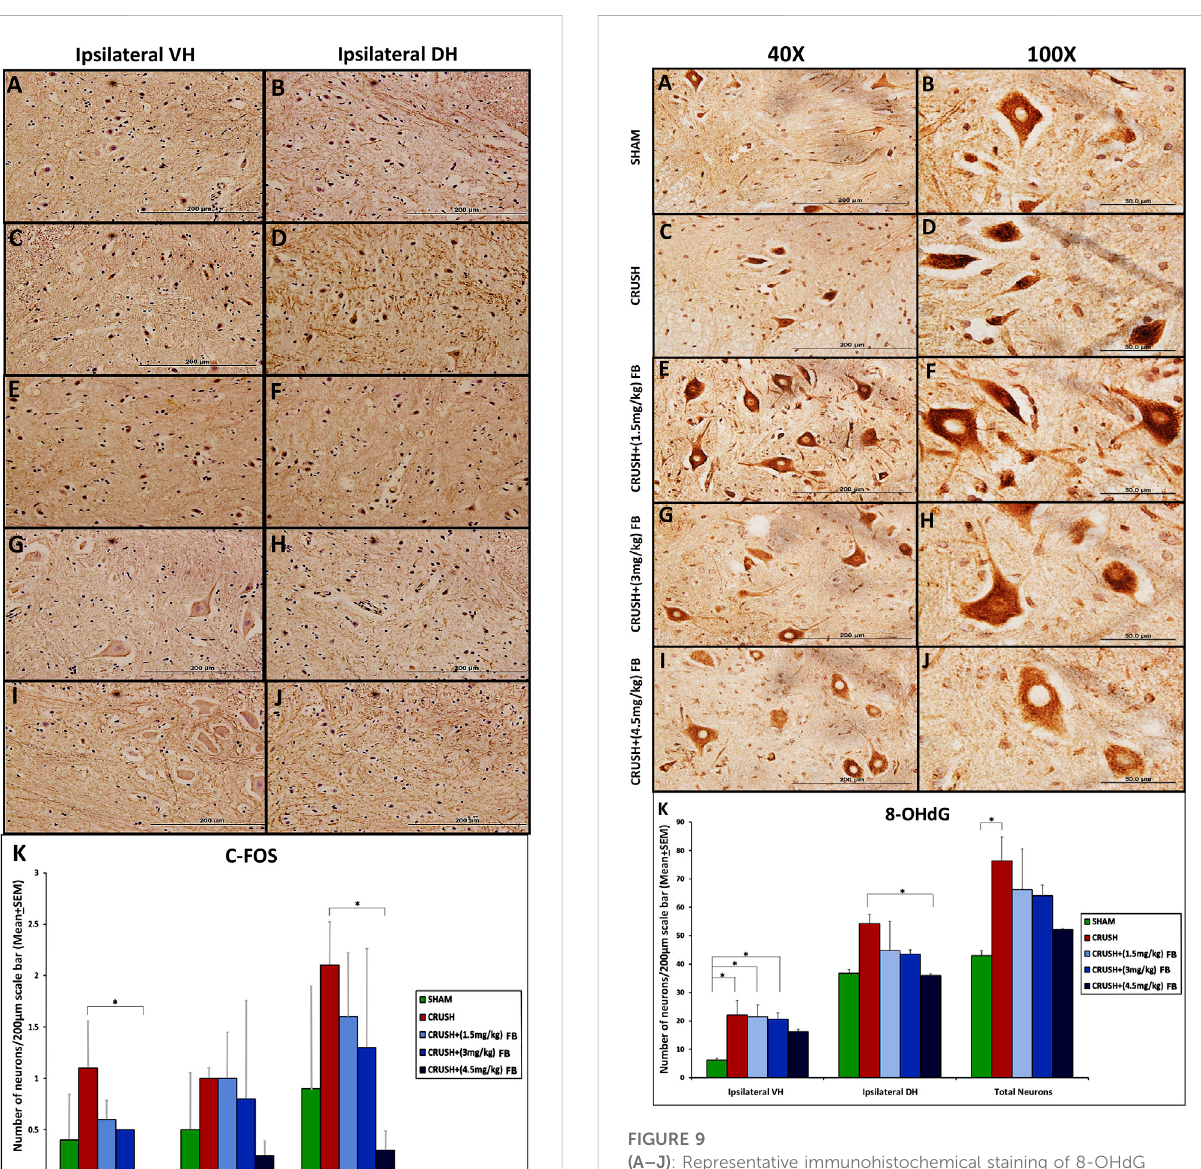
(3 mg/kg) FB were signi fi cantly lower ( p < 0.05 and p < 0.01, respectively) than the CRUSH group. CRUSH + (4.5 mg/kg) FB- treated animals demonstrated signi fi cantly higher c-Jun immunoreactive neurons in ventral and dorsal horns than (3 mg/kg) in FB-treated animals. Also, CRUSH+(4.5 mg/kg) FB-treated group showed signi fi cantly ( p < 0.05) higher expression of the c-Jun protein in dorsal horn neurons as compared to the SHAM group.